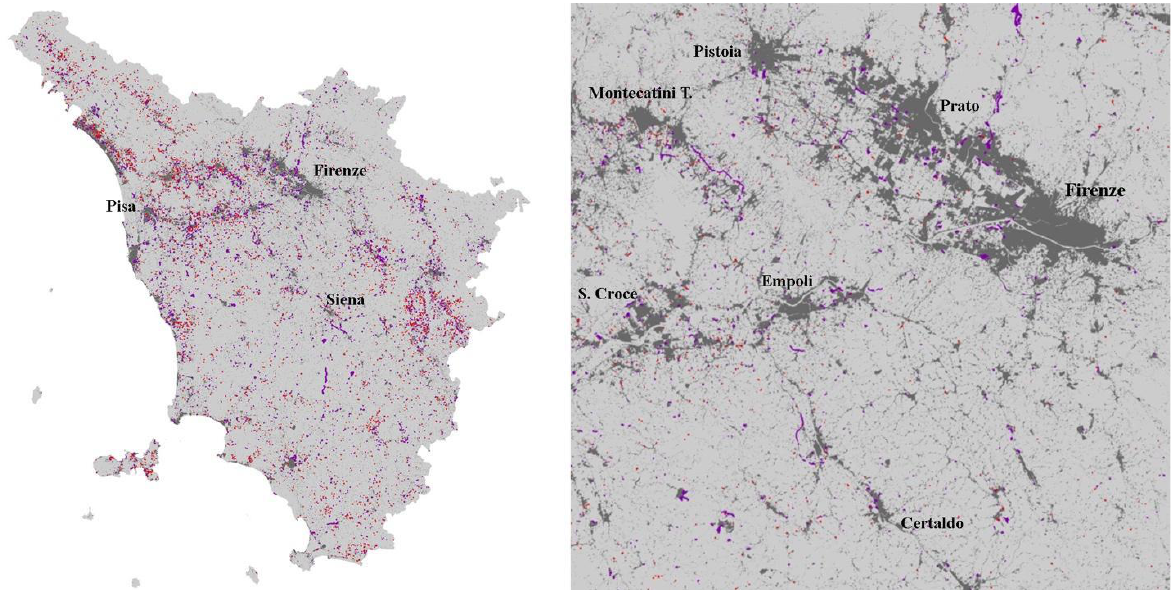
Figure 1. On the left: 2010-2016 LULC variations in Tuscany, using Land Cover Flow nomenclature. The LCF2 categories are colored red (Urban residential sprawl); the LCF3 categories are colored purple (Sprawl of economic sites and infrastructures); the artificial surface present in 2010 and also in 2016 are colored in dark grey. On the right: Details of the 2010-2016 LULC variations around